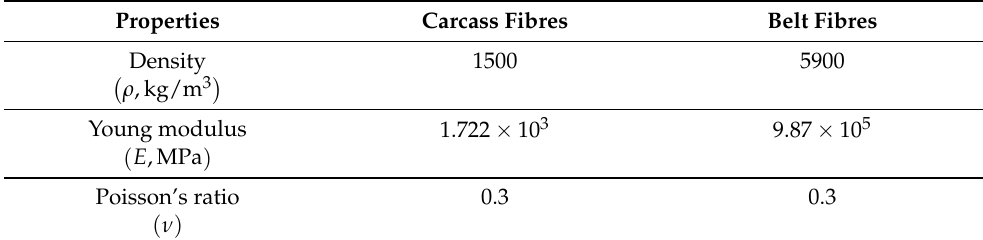
Table 2. Material properties of reinforcing fibres in carcass and belts of the tire